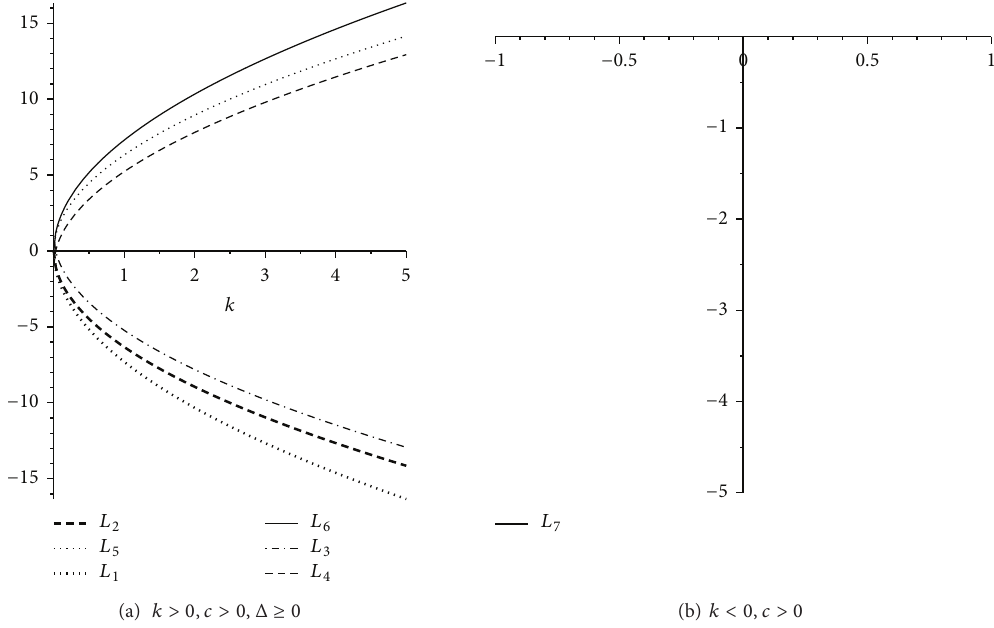
Figure 1: Transition boundaries on ( 𝑘 − 𝑟 ) plane of system